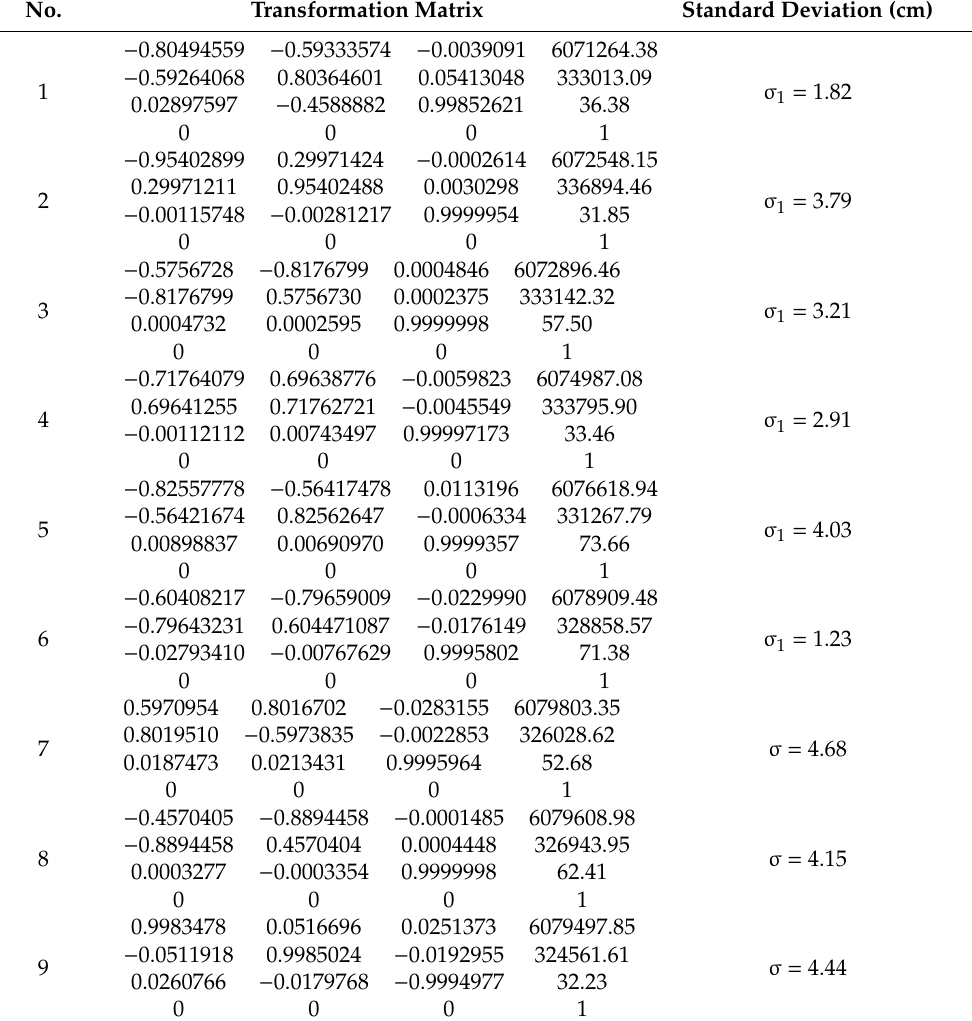
Table 4. Ground control network transformation